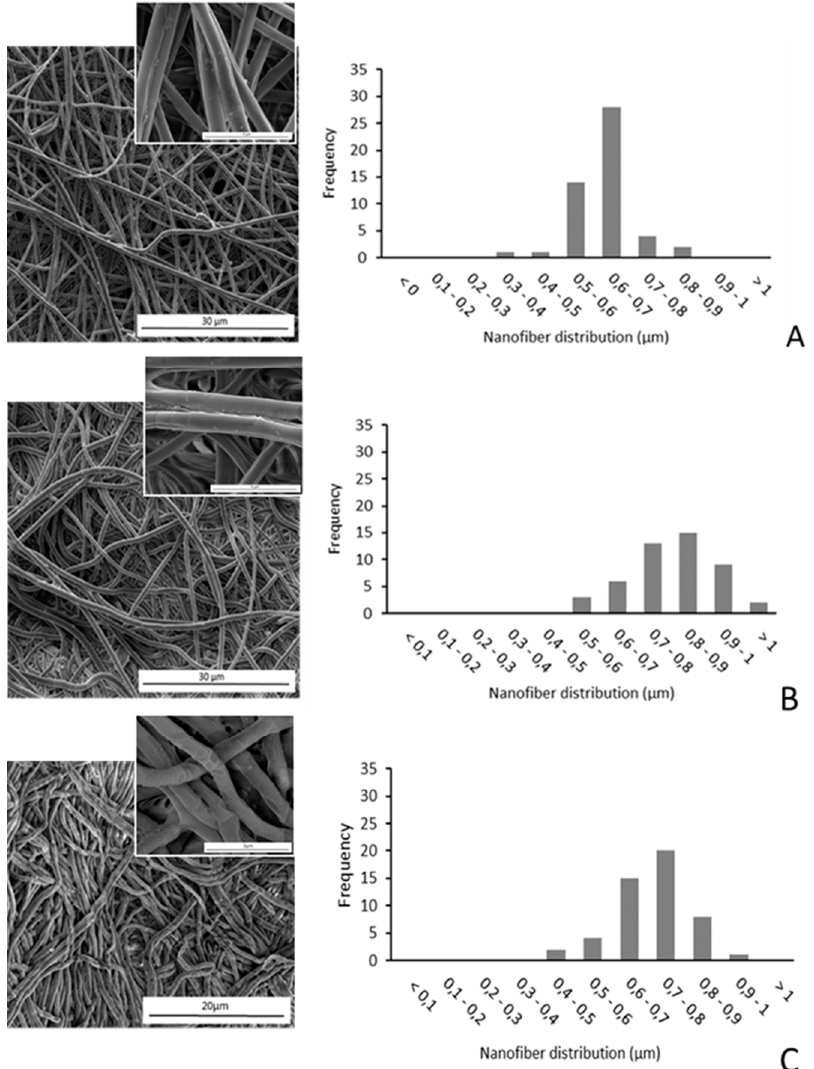
Figure 4. SEM micrographs (left) and size-distribution of fibers (right), expressed as % number (frequency), prepared from PLA solutions containing various amounts of RSV after a 46-day release test: ( A ) PLA-RSV1, pH 4.8, ( B ) PLA-RSV2, pH 4.8, ( C ) PLA-RSV2, pH 6.8.